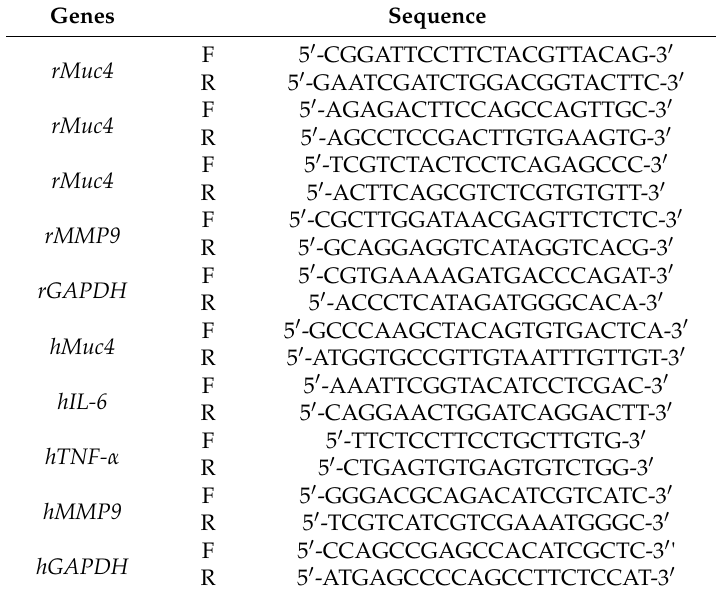
Table 1. Realtime PCR (polymerase chain reaction) primer sequences.